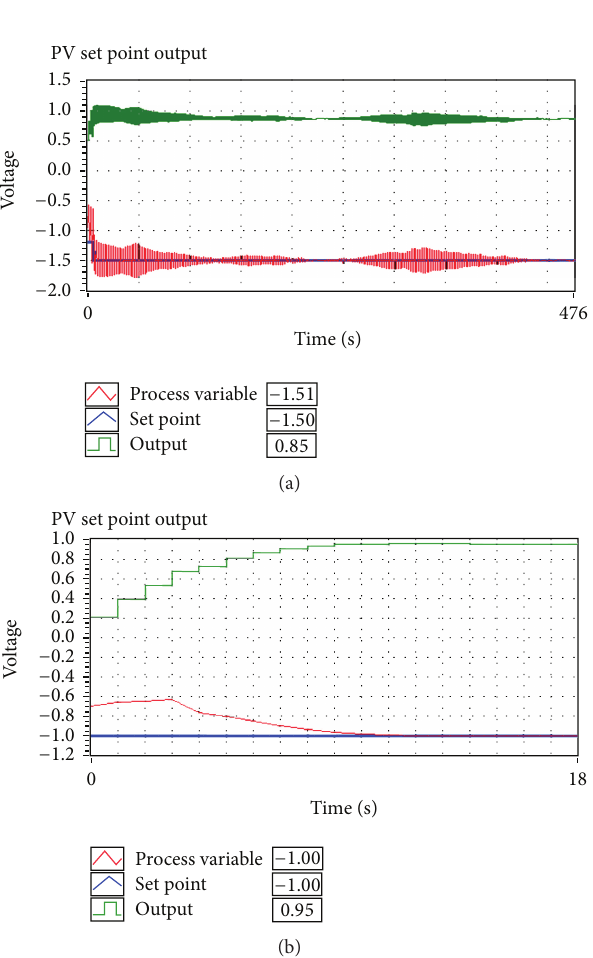
Figure 7: Controller performances when operated in Auto PSP control mode. Figure 8: (a) PI controller startup curve (